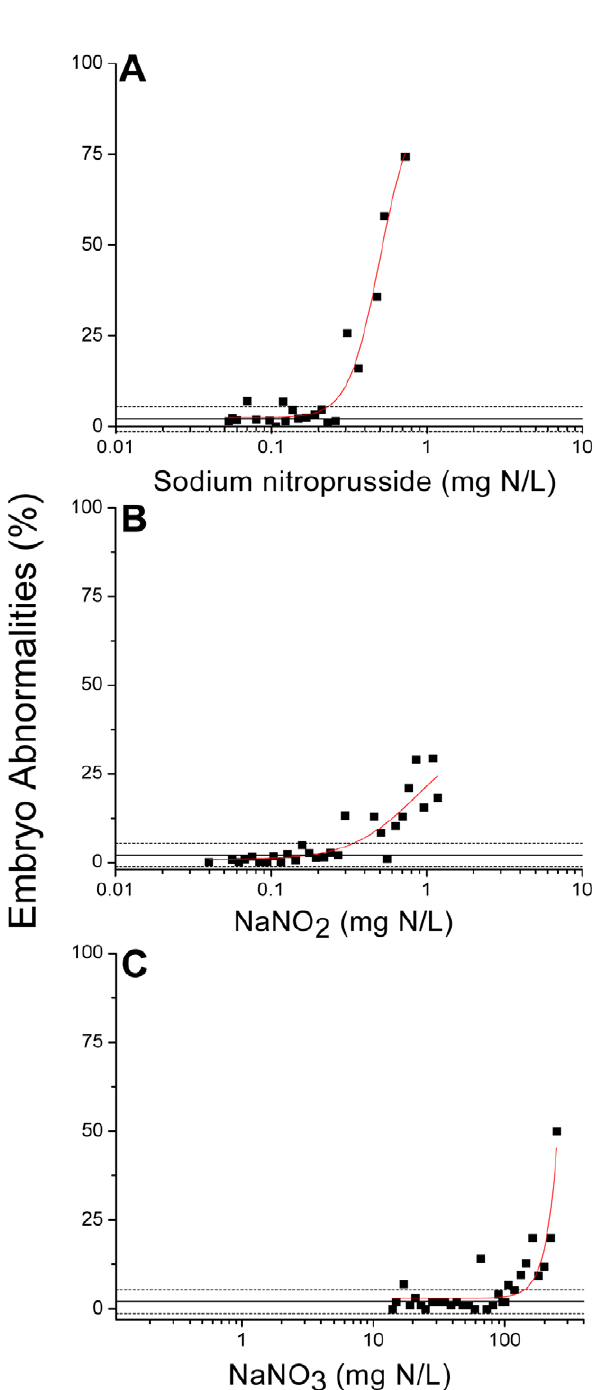
Figure 5. Frequency of neonatal abnormalities among daph- nids exposed to increasing concentrations of (A) sodium nitroprusside, (B) NaNO 2 , or (C) NaNO 3 . Each data point represents the percentage of abnormal neonates produced by a single maternal daphnid. Mean 6 SD negative control performance is depicted by the solid line bracketed by dotted lines. doi:10.1371/journal.pone.0012453.g005 supports the premise that reproductive and developmental toxicity of NO x are due to the generation of nitric oxide. As noted above, lower potency of NO 3 2 as compared to NO 2 2 is likely due to its reduced uptake by the organisms and requirement for more extensive metabolism to generate nitric oxide.